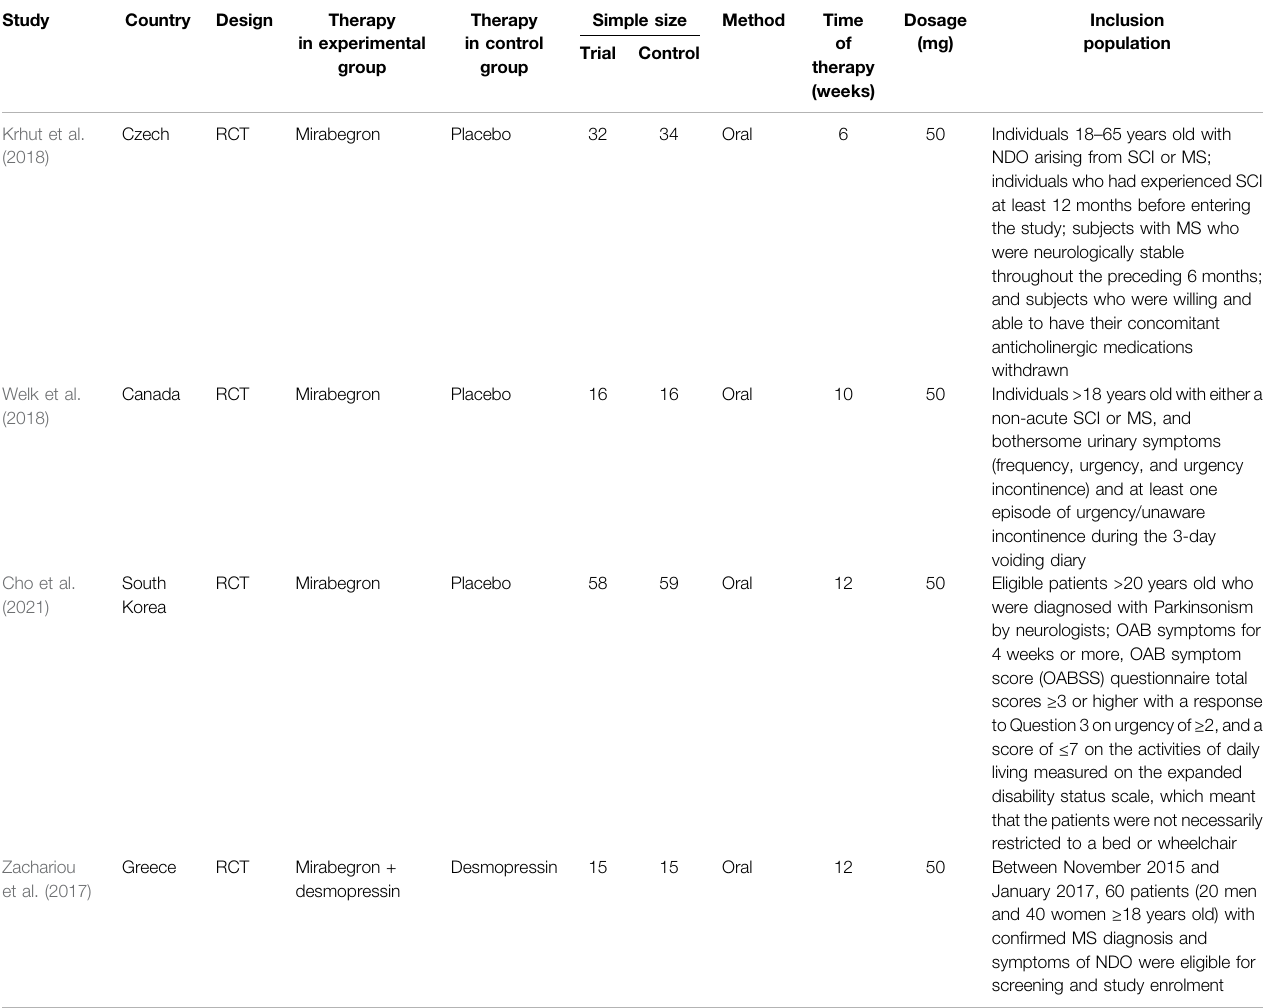
TABLE 2 | Study and patient characteristics.